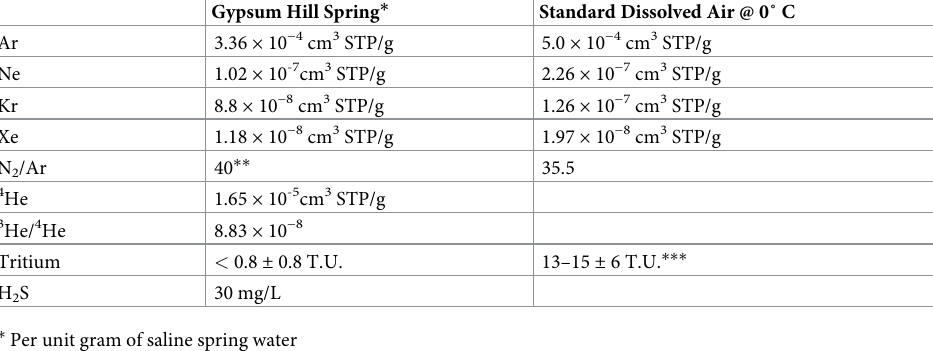
Table 2. Summary of data for gas dissolved in spring